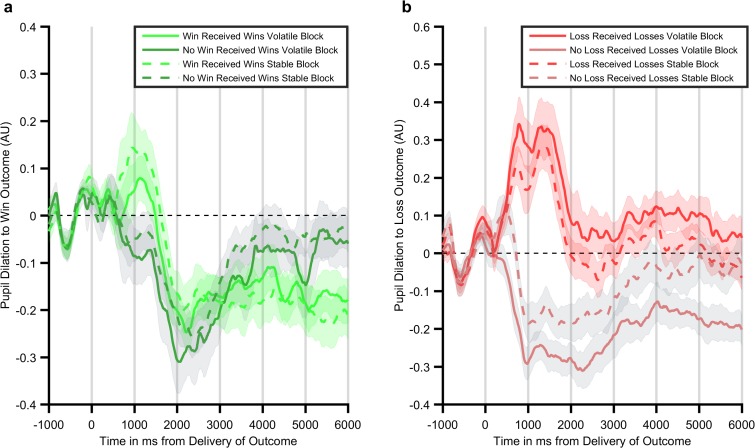
Individual time courses for trials in which wins (panel a) and losses (panel b) are either received or not received.Lines represent the mean and shaded areas the SEM of pupil dilation over the 6 s after outcomes are presented. Figure 3 illustrates the difference in pupil dilation between trials in which an outcome was received and those in which the outcome was not received. In order to further investigate this effect the mean pupil response for trials in which the outcome was and was not received have been separately plotted. As can be seen, whereas there is relatively little difference in pupil response during the win trials, there is a large difference in dilation between trials on which a loss is received and those in which no loss is received. Further, the effect of loss volatility is seen to both increase dilation on receipt of a loss and reduce dilation when no loss is received, suggesting that the effect of the volatility manipulation is to exaggerate the effect of the outcome.